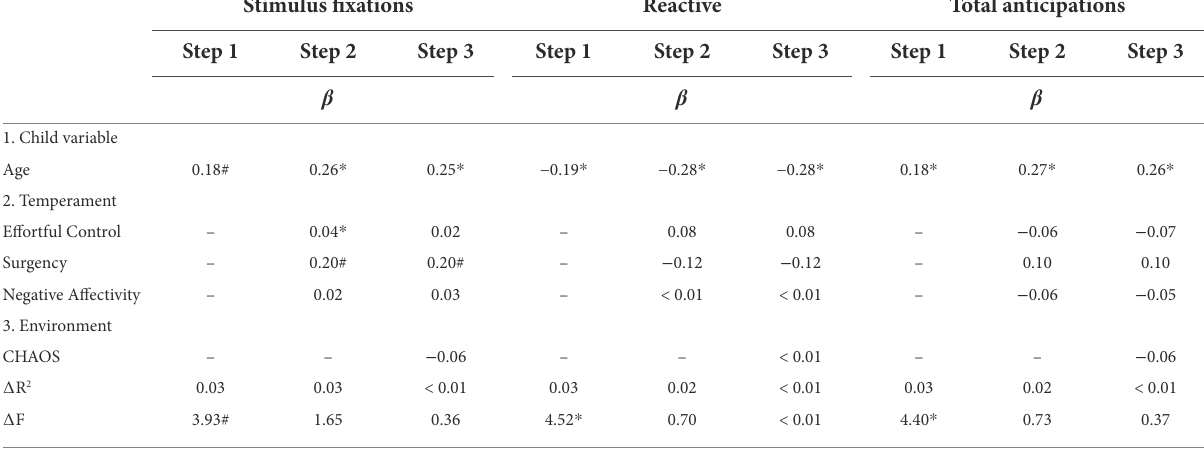
TABLE 6 Regression coefficients for stimulus fixations, reactive looks and total anticipations at Time 1.